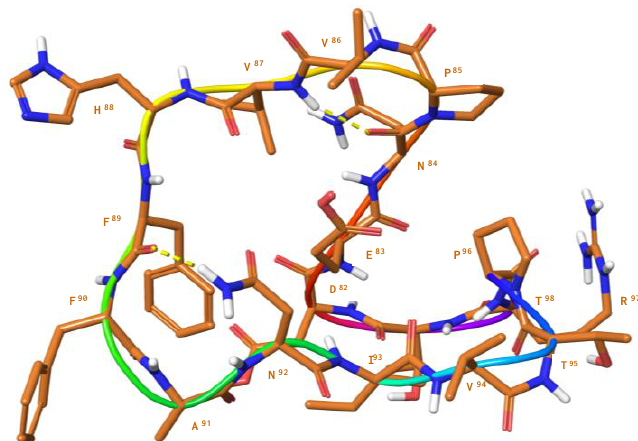
Figure 2. Low-energy conformer of cyclic MBP 82 – 98 (A 91 ) in accordance with the NOE distance constraints.